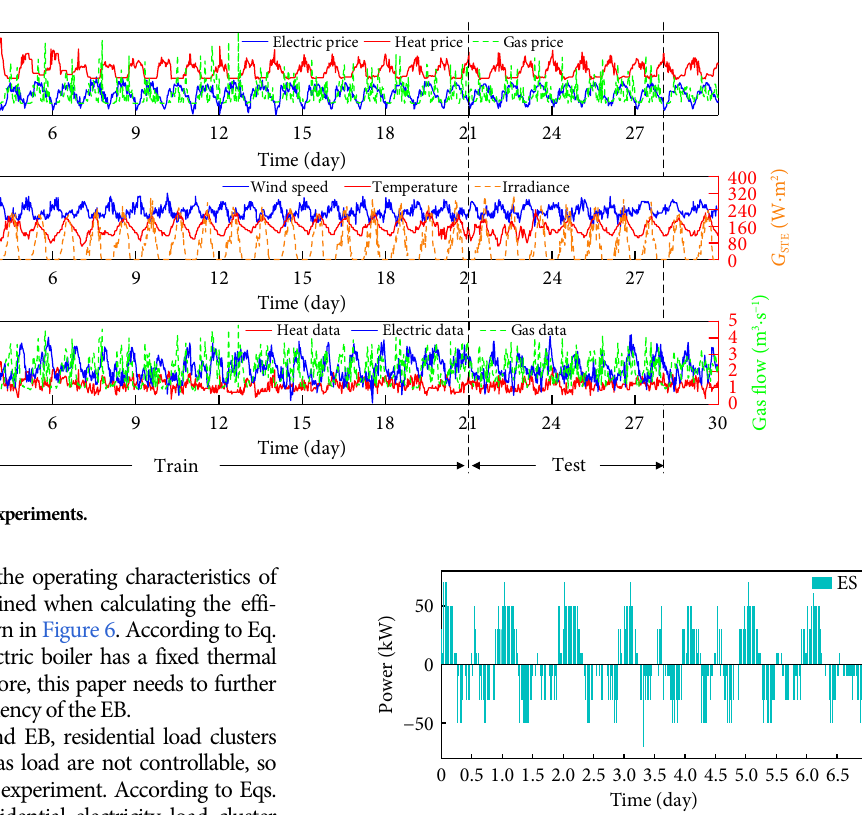
Fig. 10 Generated operating characteristics of ES.